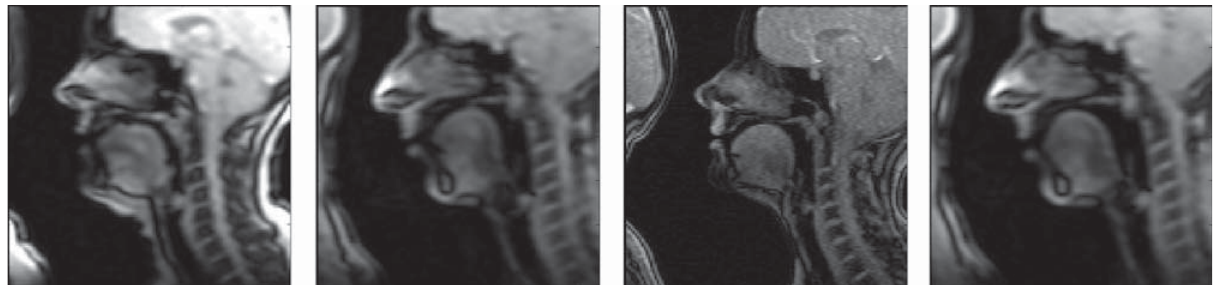
Figure 2- Cine MR Images for /i/ patient, /i/ control, /u/ patient, /u/